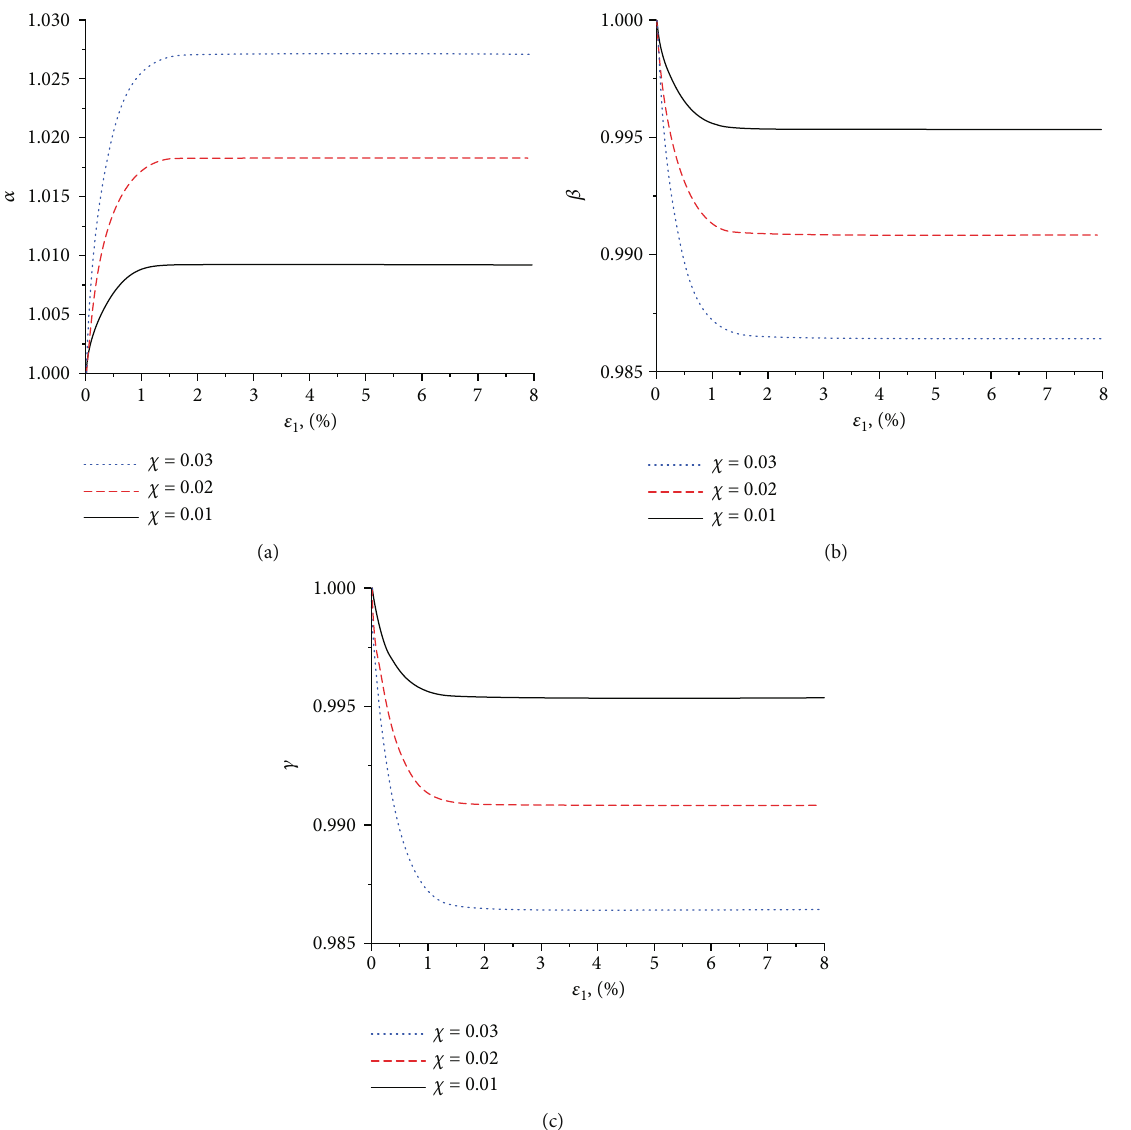
Figure 6: Changes of anisotropic parameters for various material constant: (a) α vs. axial strain; (b) β vs. axial strain; (c) γ vs. axial